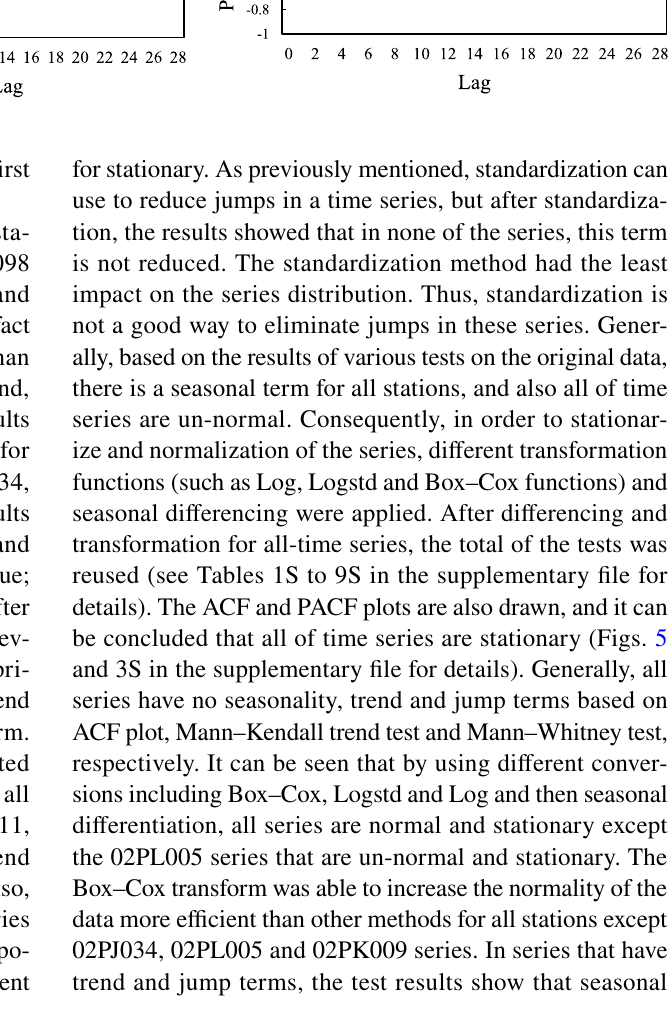
Fig. 5 ACF and PACF plots for 02PB019 station and the seasonal differentiation data in the calibration